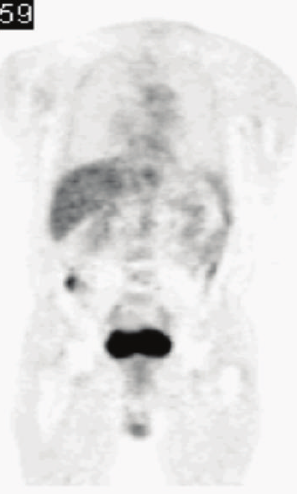
Figure 4: Pre-existing lesion of the colon missed on